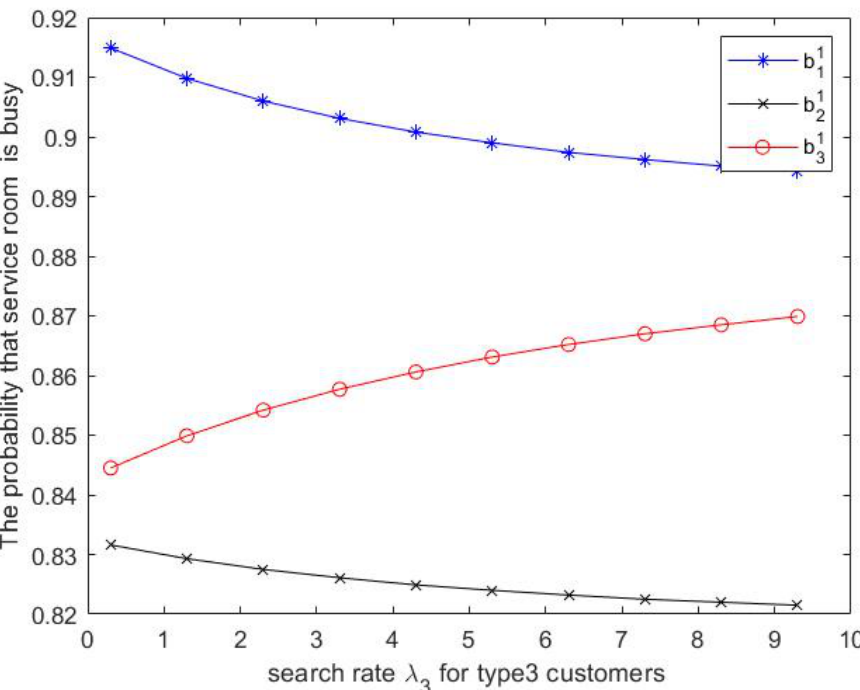
Figure 13. Effect of λ 3 on probability that the service room is